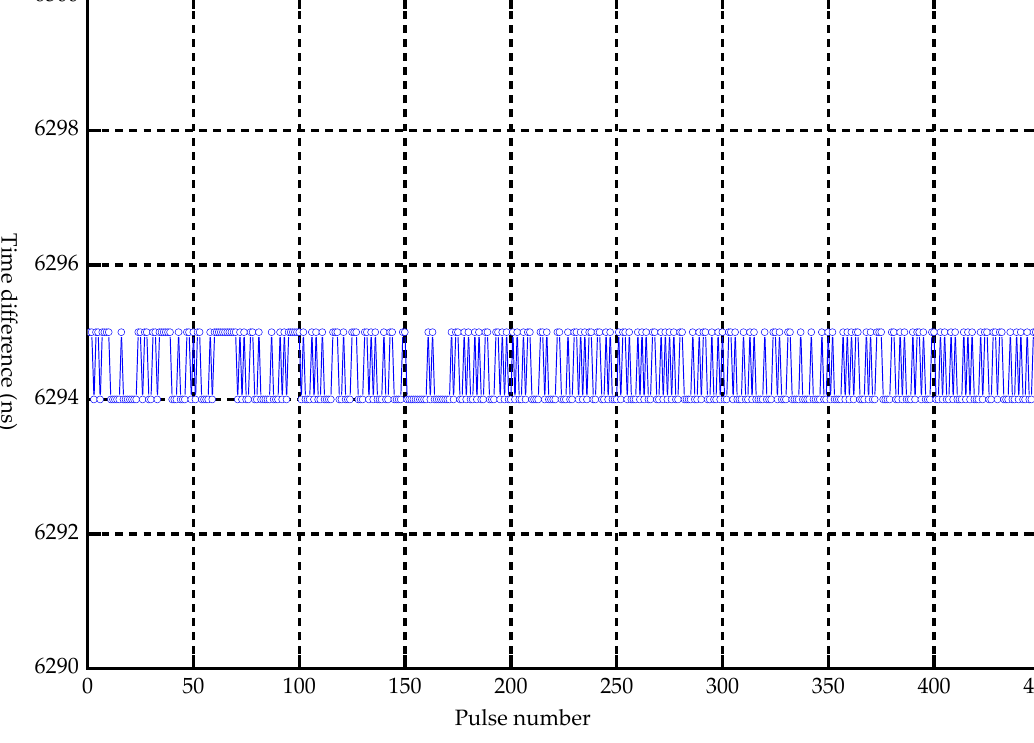
Pulse number Figure 7. Corresponding distance measurement error.